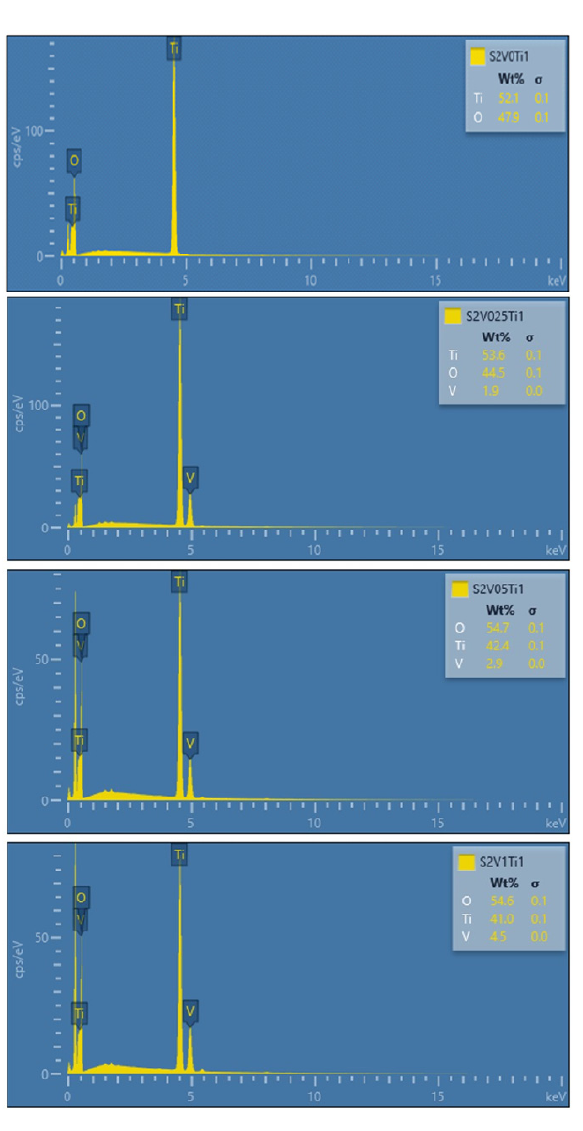
Figure 4. EDS spectra of the obtained materials.